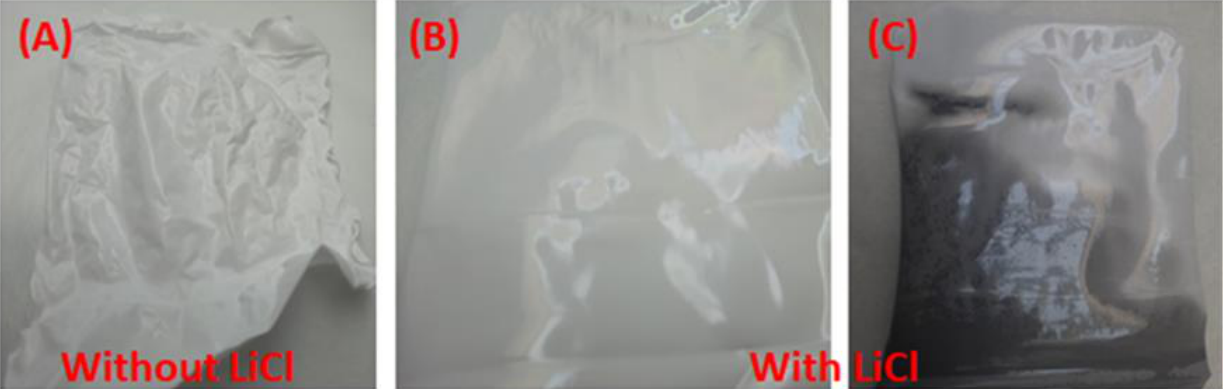
Figure 2. Photos illustrating the effect of the addition of lithium chloride (LiCl) on shrinkage in the prepared blank cellulose acetate (CA) and magnetic mixed CA matrix membranes after drying in atmospheric air. The blank CA without ( A ) and with ( B ) LiCl and the magnetic mixed CA matrix membrane with LiCl (0.1 wt.%) ( C ).